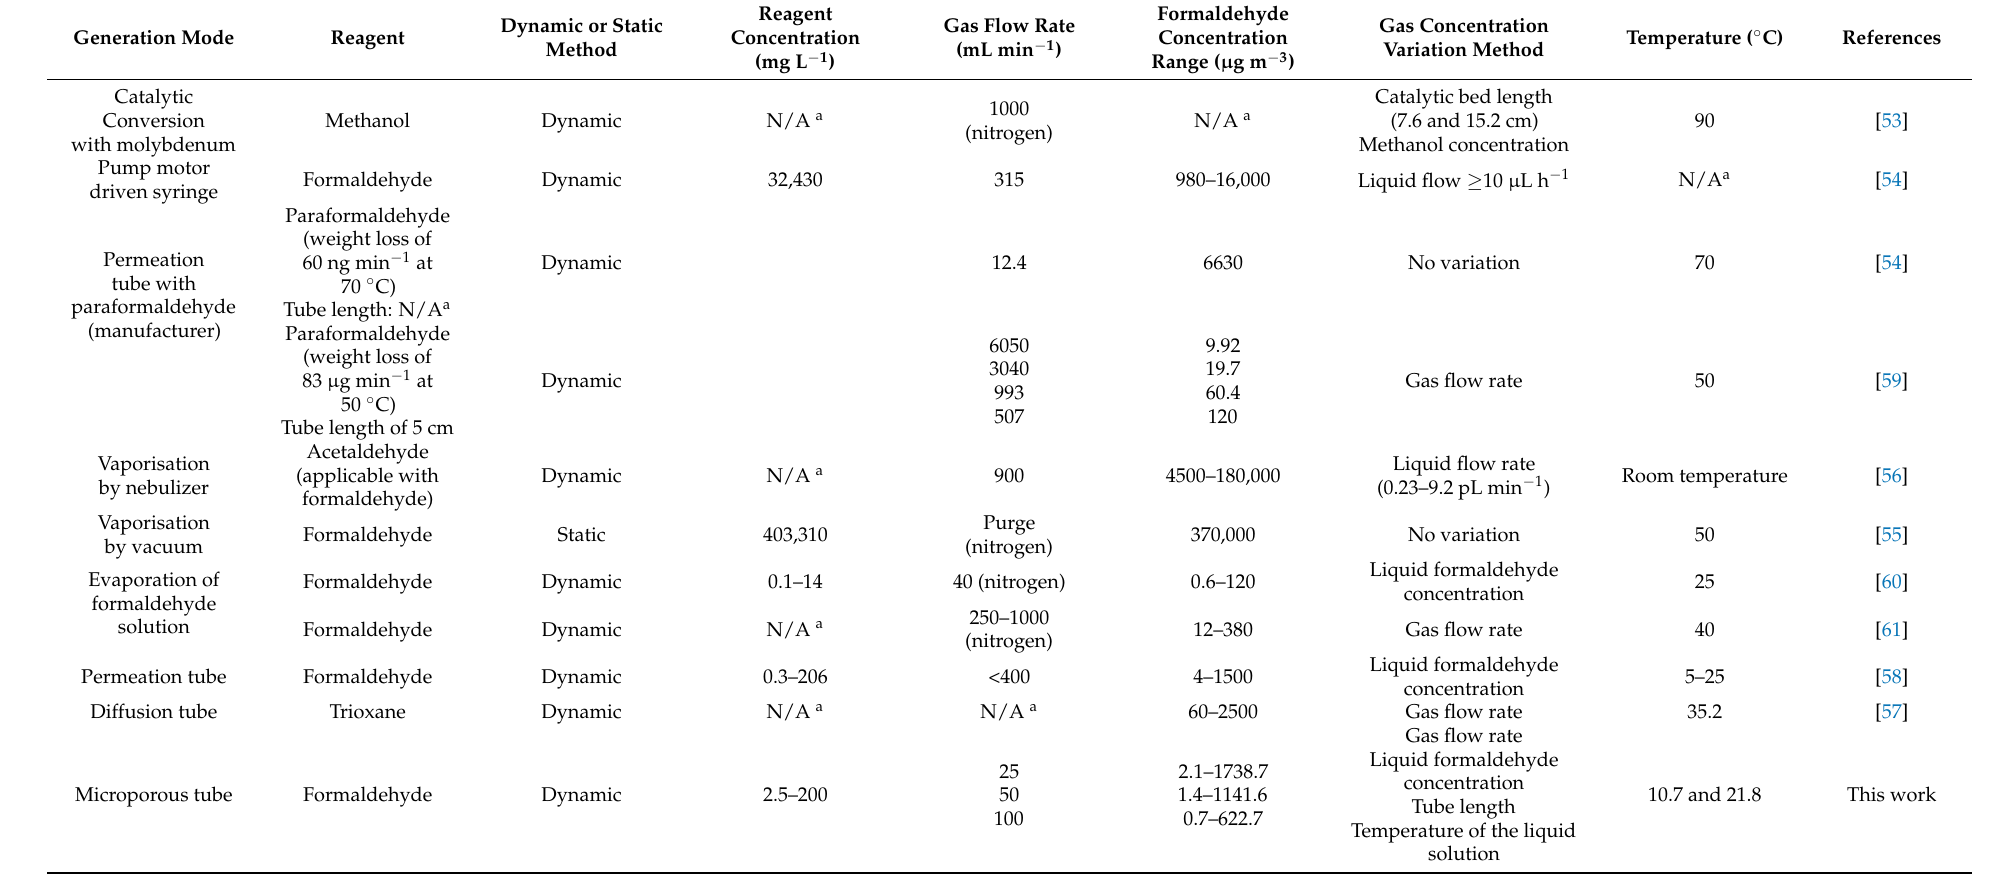
Table 1. Devices for generating gaseous formaldehyde from liquid or solid